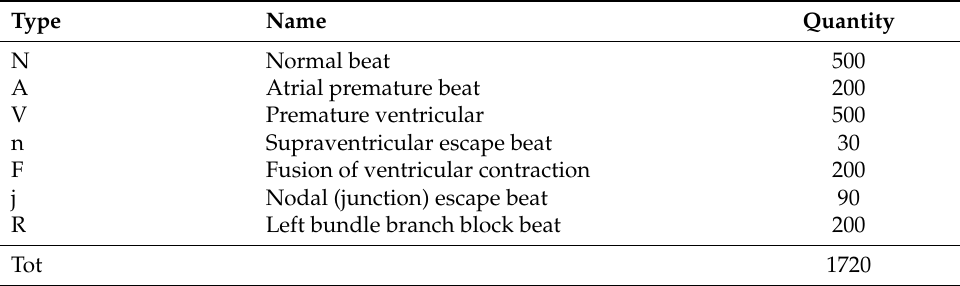
Table 2. Details of the categories for INCART database.